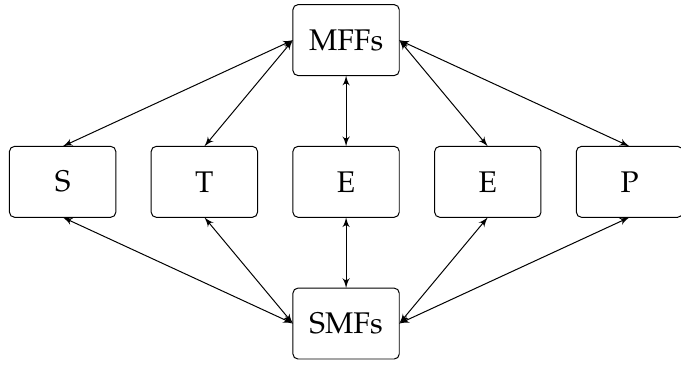
Figure 4. STEEP model